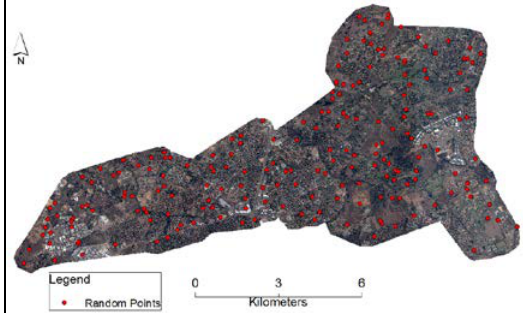
Figure 2: Illustration of sample distribution of accuracy assessment points in the study